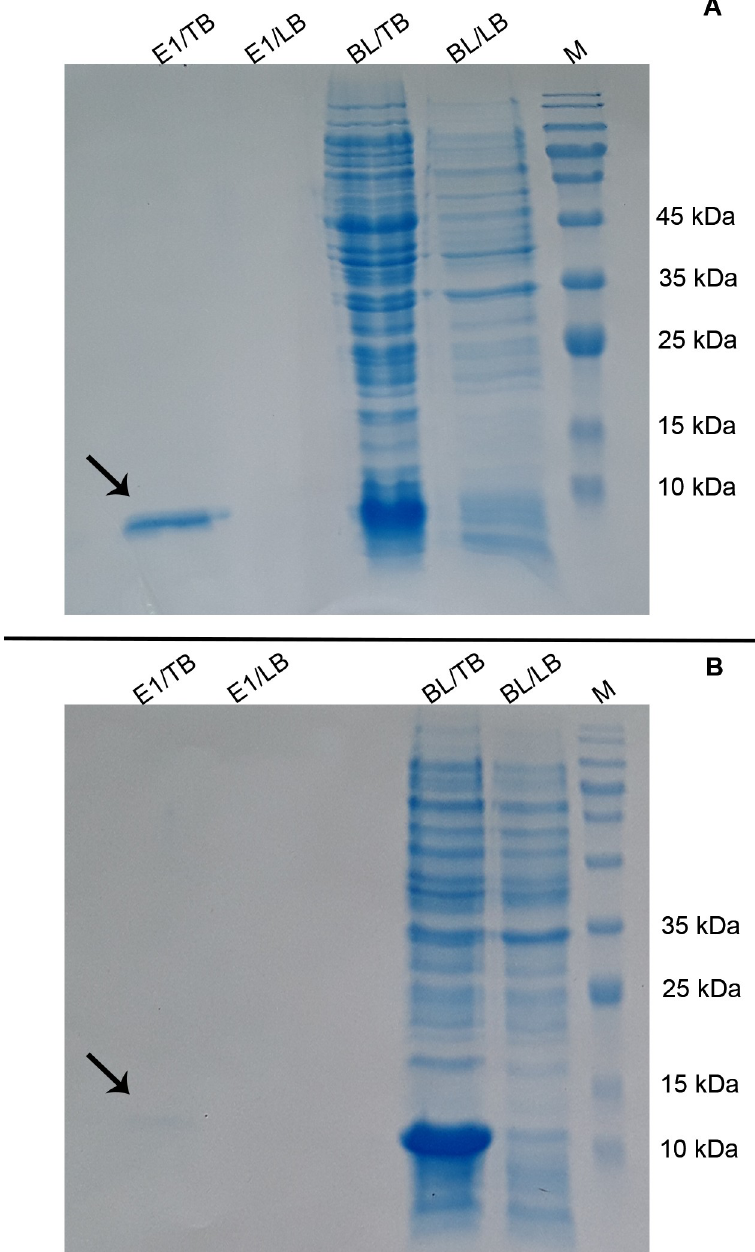
Fig 5. Investigating the rPF4 secretion through the T1SS and T2SS. Protein expression and secretion were carried out in 7 mL of LB or TB media for 18 h. Induction was triggered at 0.5 mM IPTG. BL refers to the cleared bacterial lysate. E1/TB and E1/LB indicate the secreted rPF4 proteins in TB or LB media respectively following purification. (A) Represents the T2SS-mediated rPF4 protein secretion into the extracellular milieu using pelB leader peptide. (B) Represents the T1SS-mediated rPF4 protein secretion into the extracellular milieu using HLA signal peptide. As demonstrated in the figures, the T2SS is more efficient in secreting the rPF4 compared to the T1SS. Furthermore, as confirmed by the SDS-PAGE analysis, growth in the TB medium enhances the protein secretion process and is superior to the LB medium.